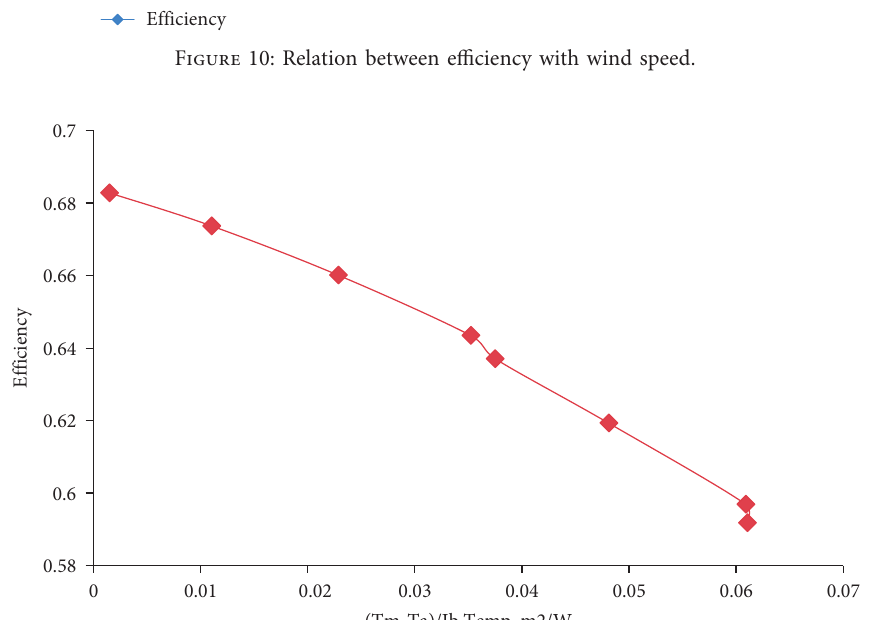
Figure 11: Relation between efficiency with work temperature divided to solar